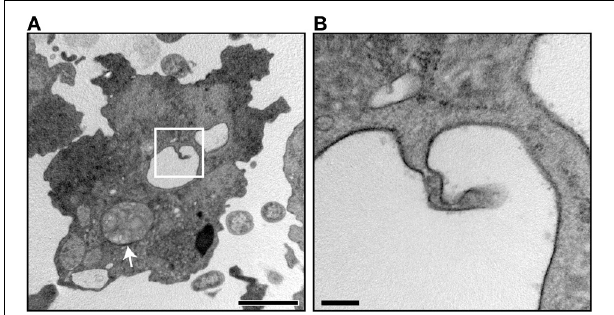
FIGURE 4 | Intra-lysosomal profile of D. discoideum cells fed digestible bacteria. (A) Transmission electronic micrographic image of a D. discoideum DH1-10 cell (Cornillon et al., 2000) with a lysosomal compartment displaying an intra-lysosomal profile (white square) and a MLB inside a lysosomal compartment (white arrow). B. Magnification of image A showing the inward bud in greater detail. The inward budding is in a lysosomal compartment containing no other electron dense material. The invaginations of the lysosomal membrane are hard to detect in compartments already containing MLBs because the compartments are too crowded. Scale bar = 2 µ m in (A) and 0.2 µ m in (B)